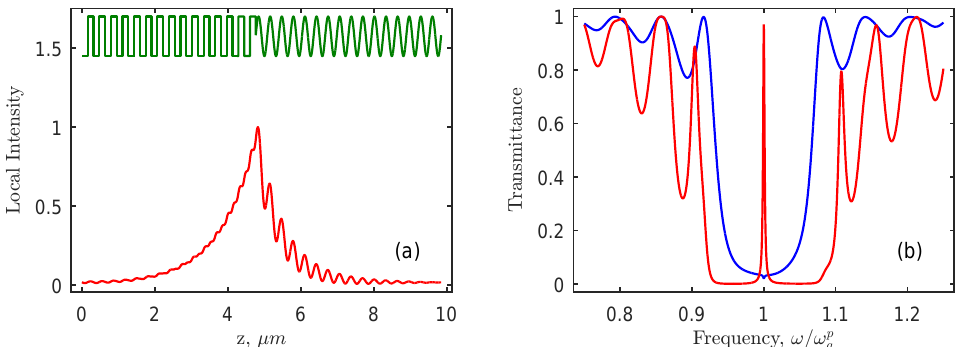
Figure 2. ( a ) The effective reflective index (green) depending on the depth z of the layered structure and normalized local intensity | E | 2 of the chiral optical Tamm state (red). ( b ) The transmission spectra for circular polarizations coinciding (red) with and opposite (blue) to the handedness of the cholesteric: The refractive indices of the ordinary and extraordinary beam for polarization-preserving anisotropic mirror (PPAM) and cholesteric liquid crystal (CLC) coincide and correspond to common values for nematic liquid crystals of cyanobiphenyl series: n o = 1.45, n e = 1.7. The wavelength in the center of the bandgaps of both crystals is λ c g = λ p g = 1 µ m. PPAM consists of 30 layers with the total thickness 30/2( n p o + n p e ) ≈ 4.76 µ m. A CLC layer has 8 helix pitches with the total